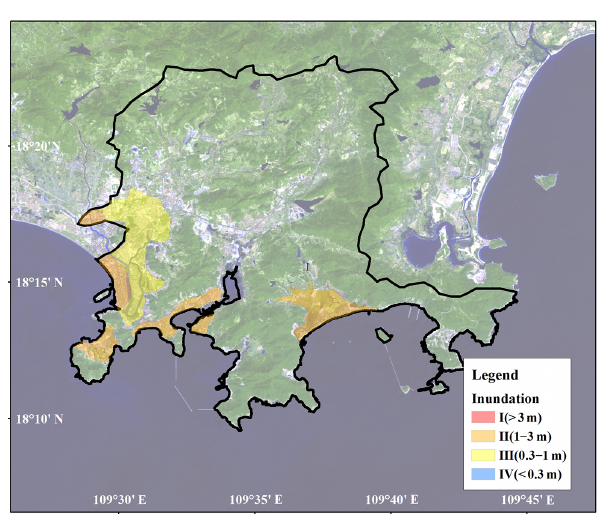
Figure 4. Inundation in the Jiyang